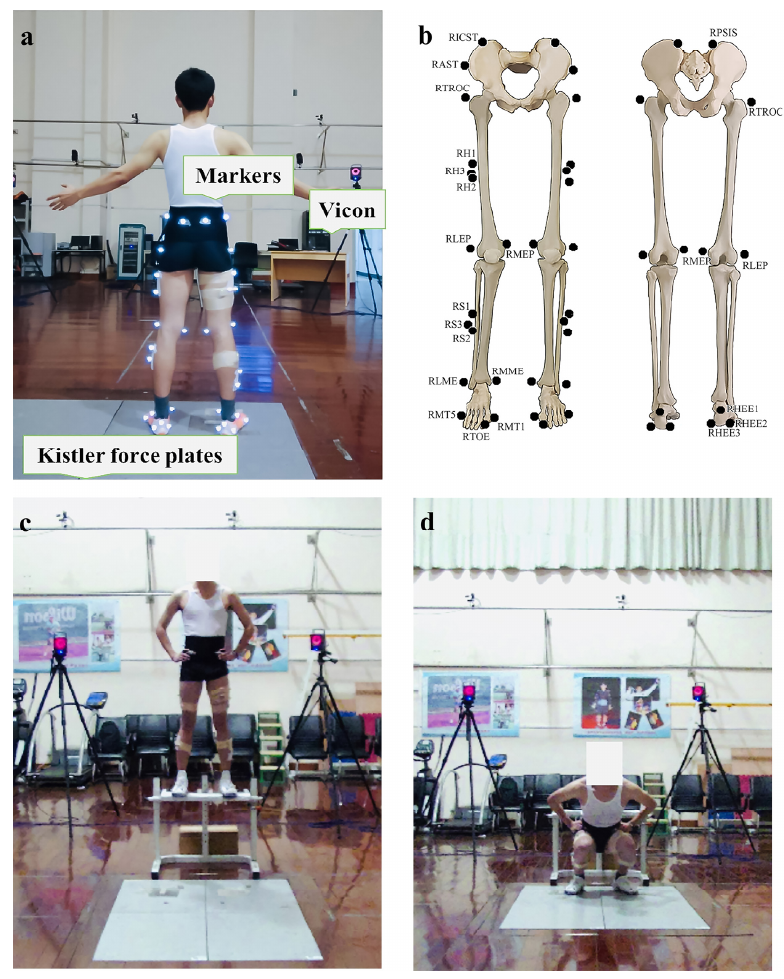
Figure 2. ( a ) experimental setup; ( b ) marker placements; ( c , d ) landing